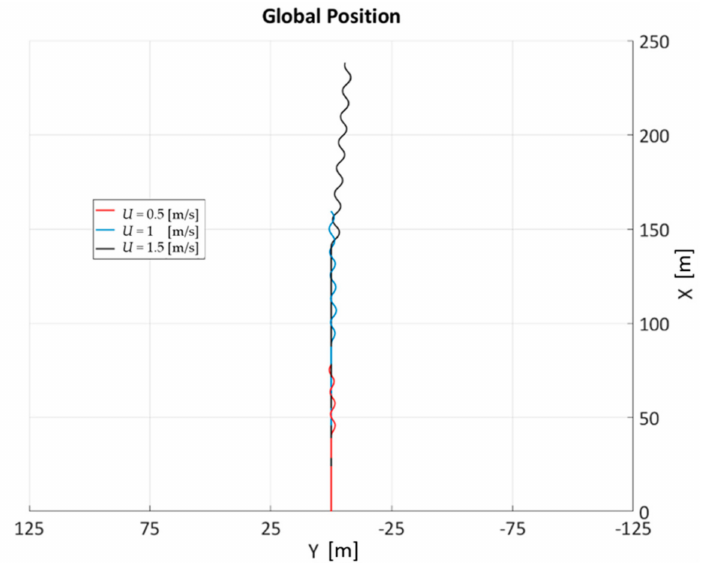
Figure 14. The SFRM’s trajectories in the horizontal zigzag test at different sailing